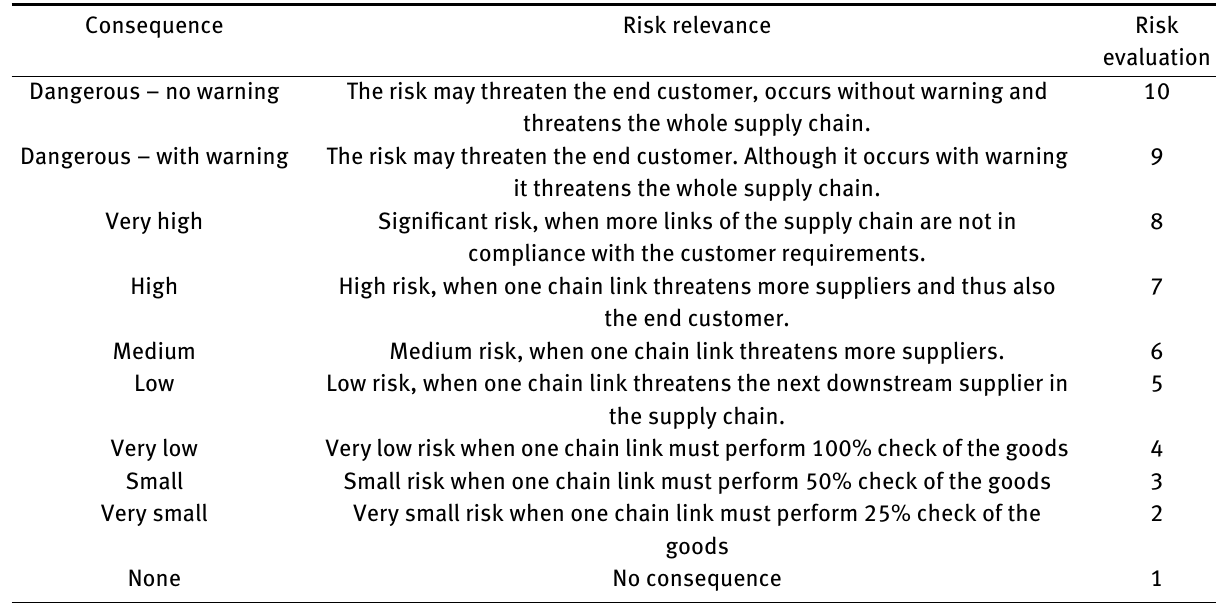
Table 2: Modified risk relevant assessment table (Source: In-house) Consequence Risk relevance Risk